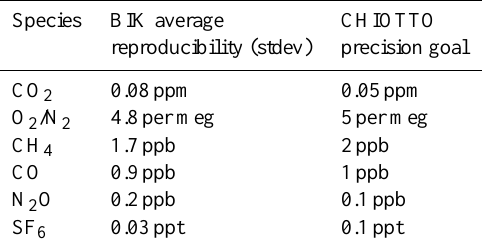
Table 2. Average precision of the measurement at Bialystok station, and the precision goals of CHIOTTO